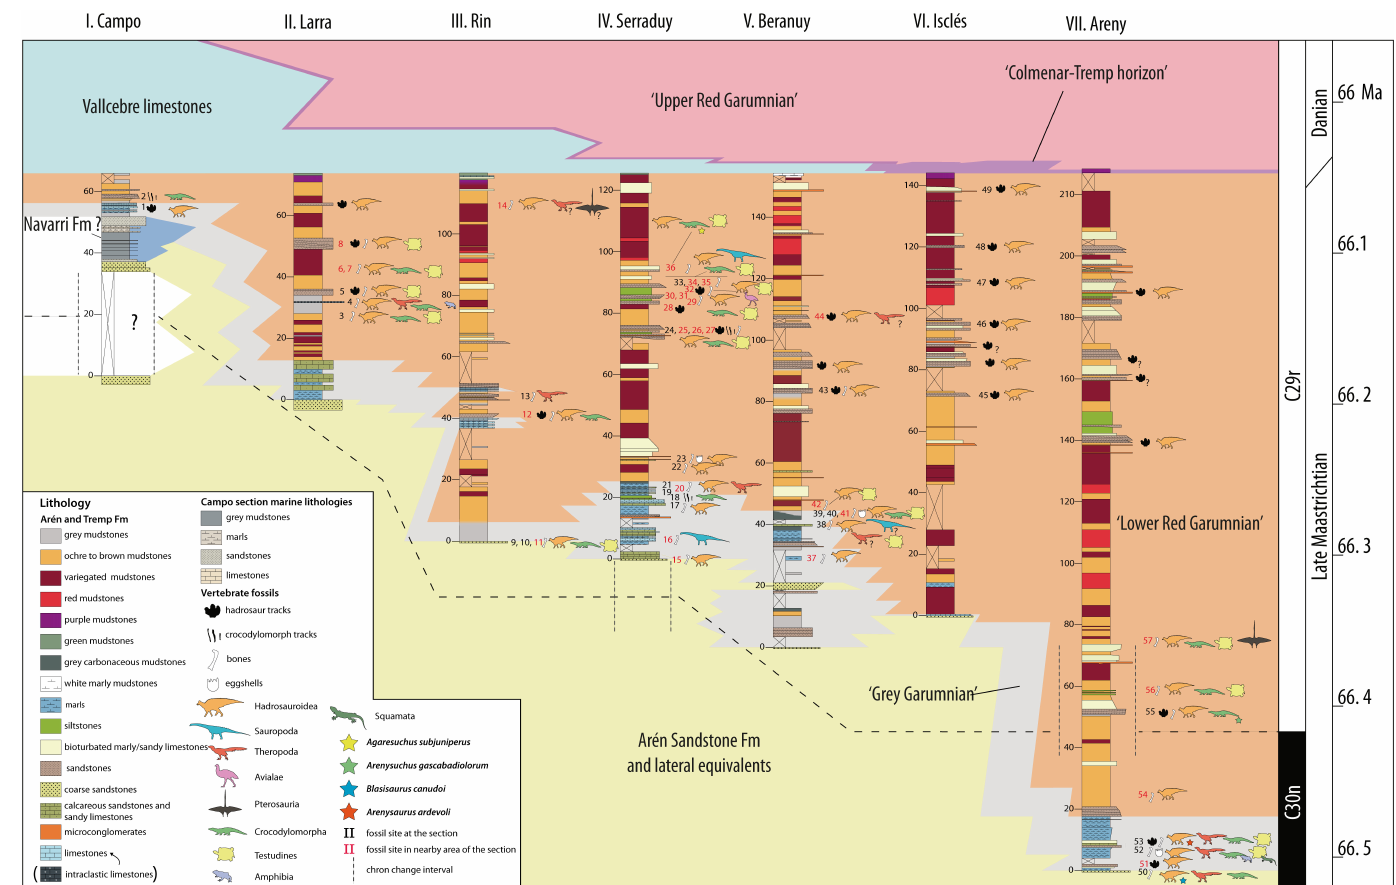
Figure 2. Correlation panel of the Western Tremp Syncline (W-E oriented) with the stratigraphic position of the vertebrate fossil sites: (1) Campo 1, (2) Campo 2, (3) Larra 3, (4) Larra 4, (5) Larra 5, (6) Larra 1, (7) Larra 2, (8) Larra 6, (9) Rin1, (10) Rin2, (11) Barranco Extremadura, (12) Pedregal, (13) Camino Rin 1, (14) Camino Rin 2, (15) Fuente San Cristobal, (16) Femur, (17) Barranco Serraduy 1, (18) Beranuy, (19) 172-i/04/d, (20) 172-i/04/c, (21) 172-i/04/e, (22) Barranco Serraduy 2, (23) 172-i/04/f, (24) Barranco Serraduy 3, (25) 172-i/04/a, (26) Color, (27) Serraduy Norte, (28) Dolor 1, (29) Dolor 2, (30) Dolor 3, (31) 172-i/04/b, (32) Amor 1, (33) Barranco Serraduy 4, (34) Barranco Serraduy 5, (35) Amor 2, (36) Amor 3, (37) Fornons 1, (38) Camino Fornons 1, (39) Camino Fornons 2, (40) Veracruz 1, (41) Fornons 2, (42) Sierra del Sis 1, (43) Sierra del Sis 2, (44) Fornons 3, (45) Iscl é s 1, (46) Iscl é s 2, (47) Iscl é s 3, (48) Iscl é s 4, (49) Iscl é s 5, (50) Blasi 1, (51) Areny 1, (52) Blasi 2a and 2b, (53) Blasi 3, (54) Blasi 3, 4, (55) Elias, (56) Blasi 4, (57) Blasi 5 (Larra log is modified from Pu é rtolas Pascual et al. (2018), magnetostratigraphic data from